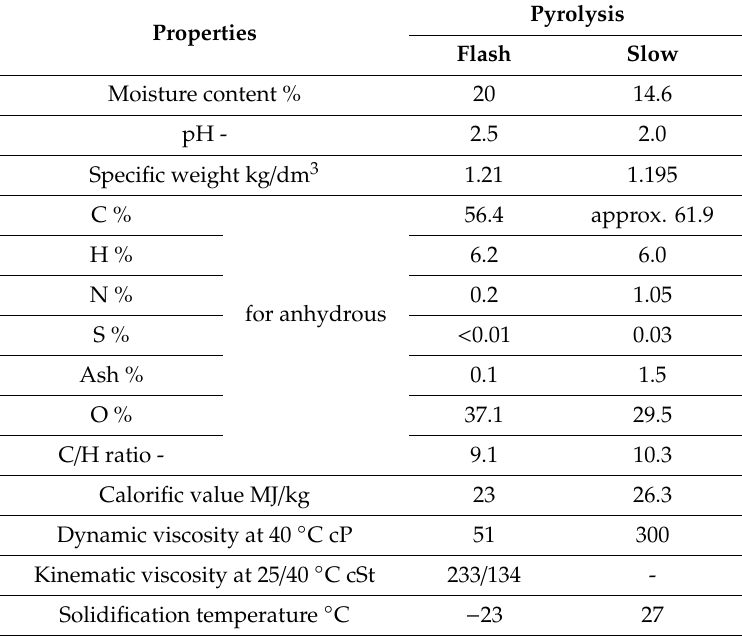
Table 3. Comparison of the properties of liquid products of flash and slow pyrolysis [17,46].